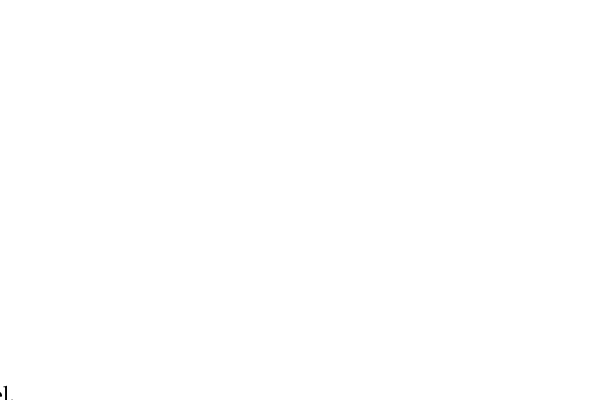
Figure 5. Numerical simulation model.